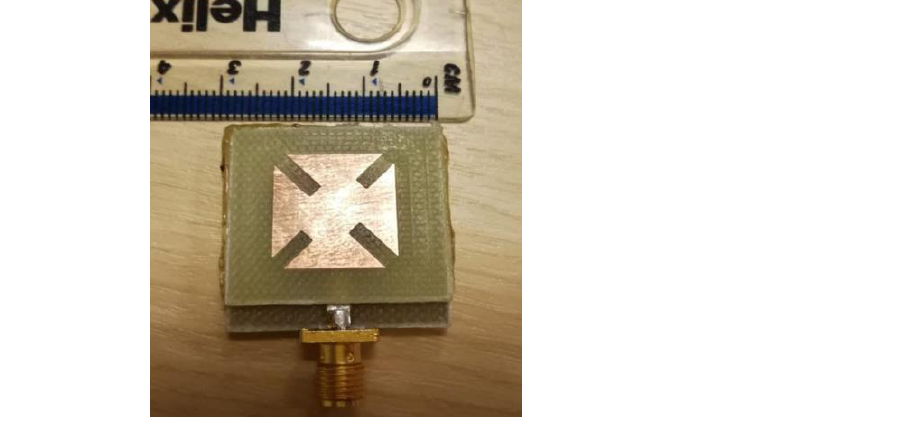
Figure 7. Prototype of the proposed single-element circularly polarized microstrip antenna.